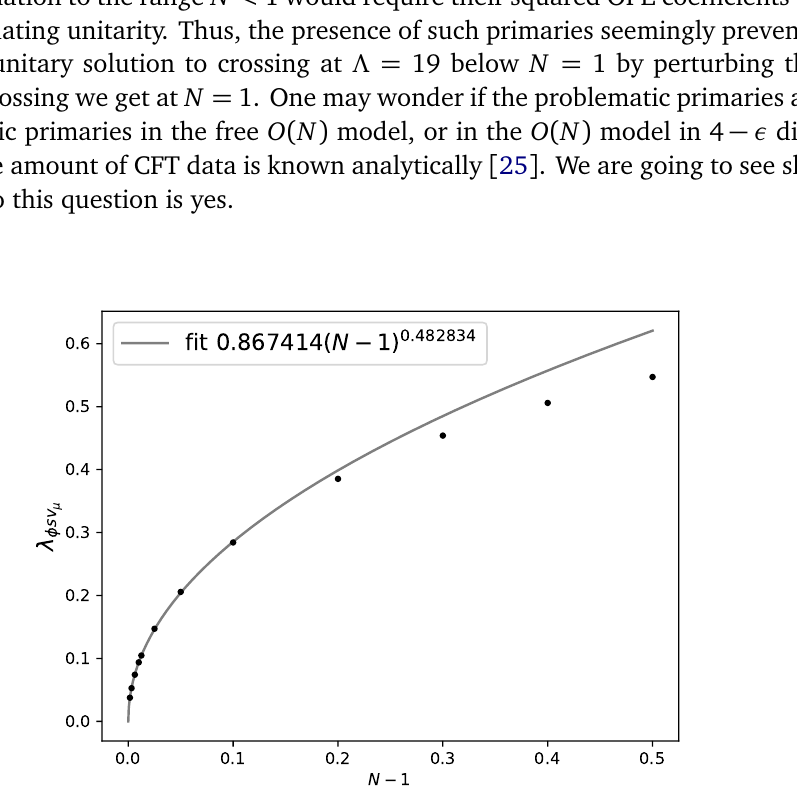
-odd primaries in the 2